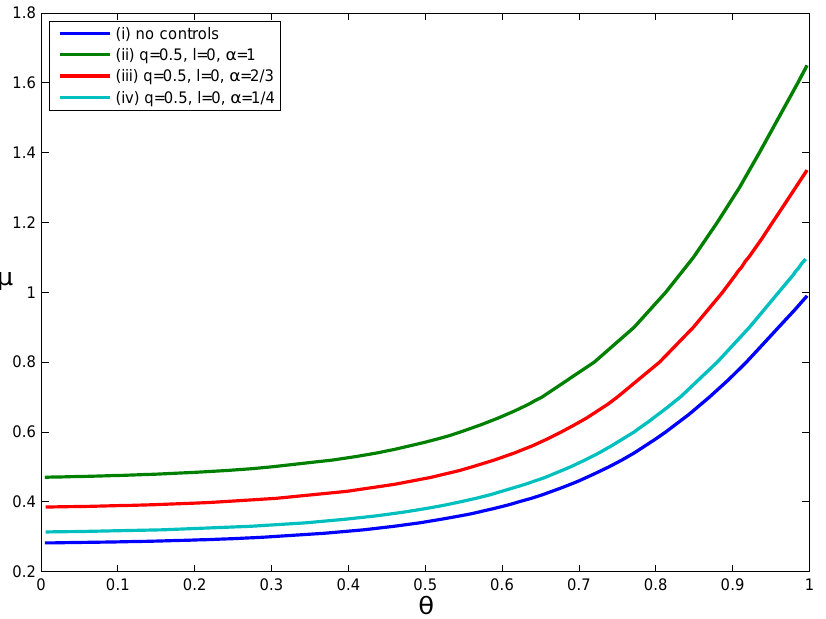
Figure 4. The impact of asymptomatic infected